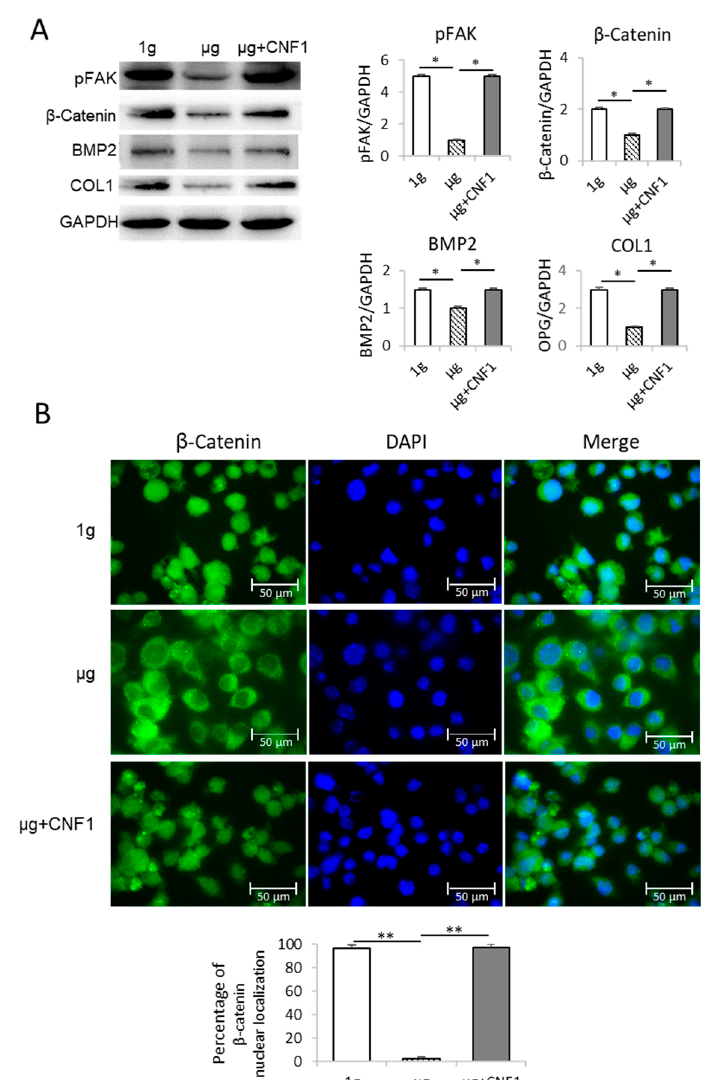
Figure 2. Analysis of FAK and Wnt/ β -catenin-regulated gene signaling and β -catenin nuclear localization in MC3T3-E1 cells cultured under different conditions. ( A ) Cell lysates prepared from MC3T3-E1 cells cultured in flasks under 1g, µg and µg + CNF1 were subjected to SDS-PAGE analysis, respectively. Proteins were transferred onto PVDF membranes and blotted with indicated antibodies. Western blot band signals were quantified by chemiluminescence. Densitometric values were normalized for matching GAPDH controls. Data represent the mean ± SD of three replicates. * p < 0.05 versus different groups by Student t test. ( B ) β -catenin nuclear localization analysis. MC3T3-E1 cells grown on chamber slides were covered using Prolong Gold Antifade Reagent with DAPI (blue) and observed by confocal microscopy. The percentages of β -catenin nuclear localization were measured by using ImageJ software. Data represent the mean ± SD. ** p < 0.01 versus different groups by using Student t test. One representative experiment of two is shown.